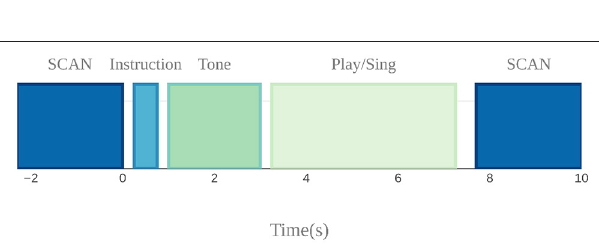
FIGURE 5 | Sparse sampling design used to avoid auditory and motion artifacts. Auditory target presentation, instruction presentation, and singing and cello playing were done in the silent 7.7 s period between